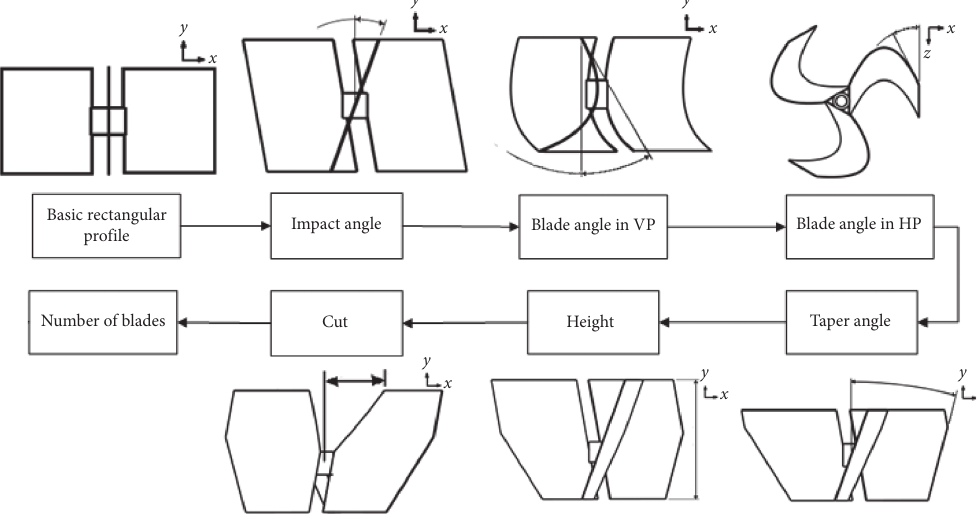
Figure 4: Flow of parameters